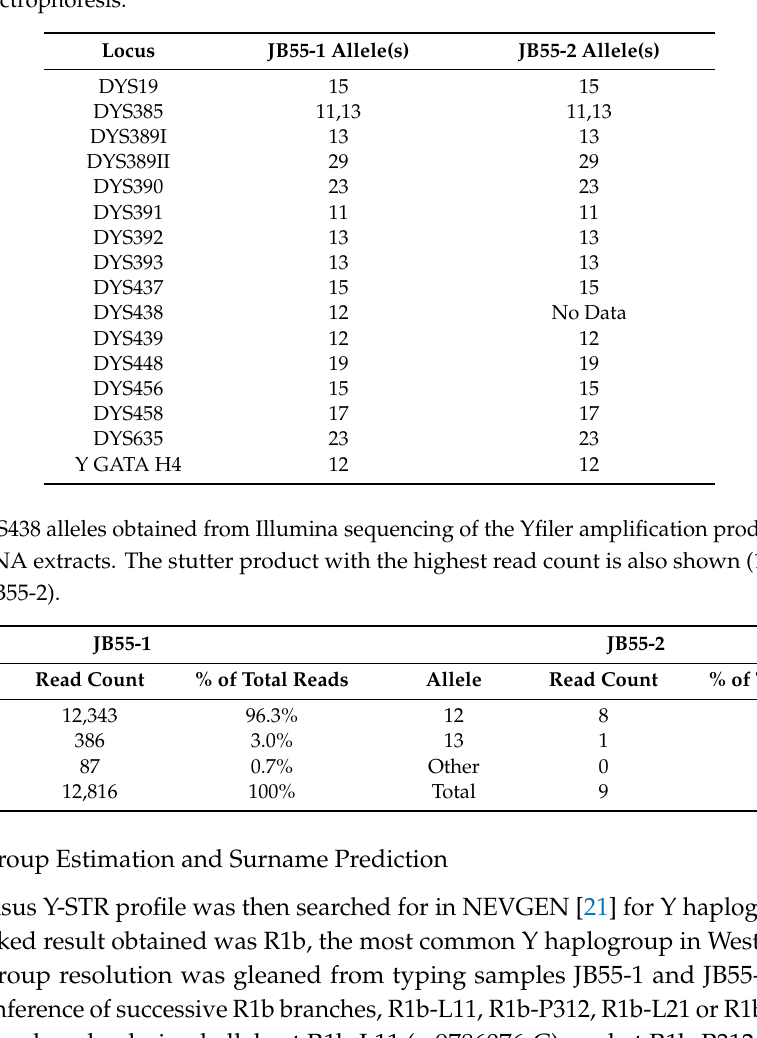
Table 2. Y-chromosomal short tandem repeat (Y-STR) profiles obtained from each of the two JB55 DNA extracts using a low copy number AmpFISTR Yfiler amplification procedure and allelic separation by capillary electrophoresis.